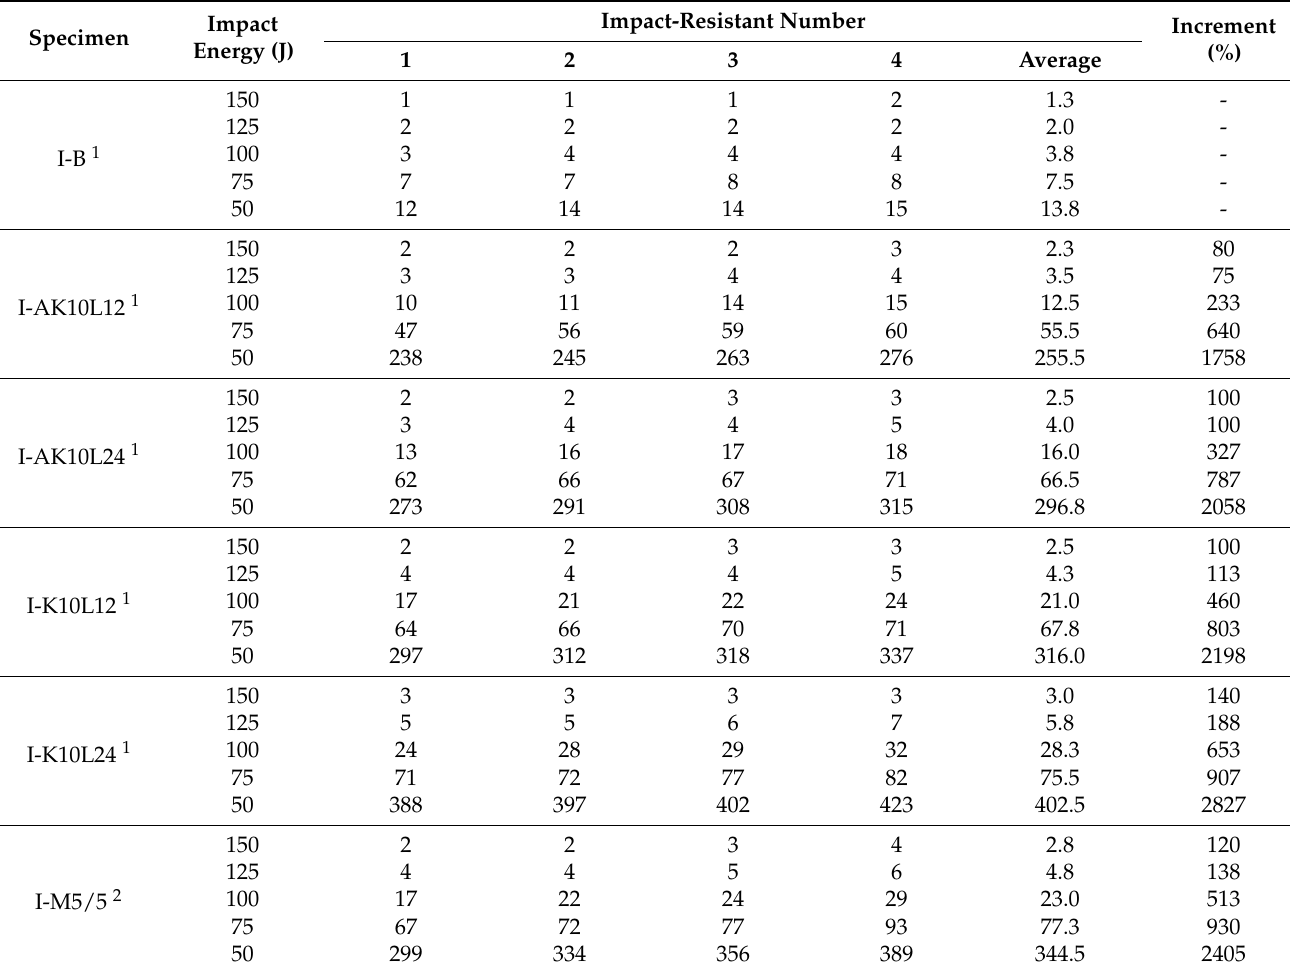
Table 10. Impact energy − number relationships of the benchmark specimens and the KFRC